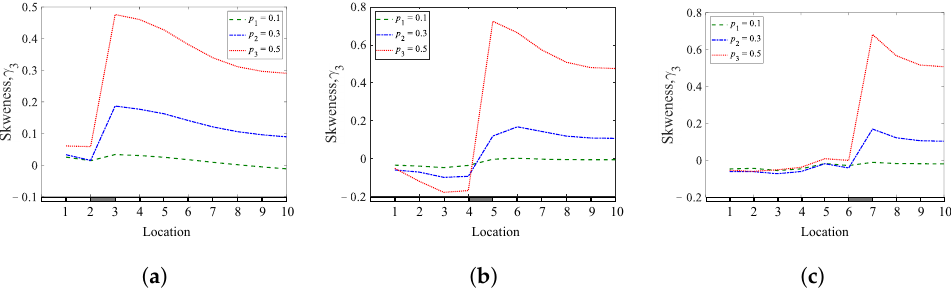
Figure 10. Skewness coefficients of a cantilever beam for different crack depths and locations: ( a ) q 1 = 0.25; ( b ) q 2 = 0.45; ( c ) q 3 = 0.65.